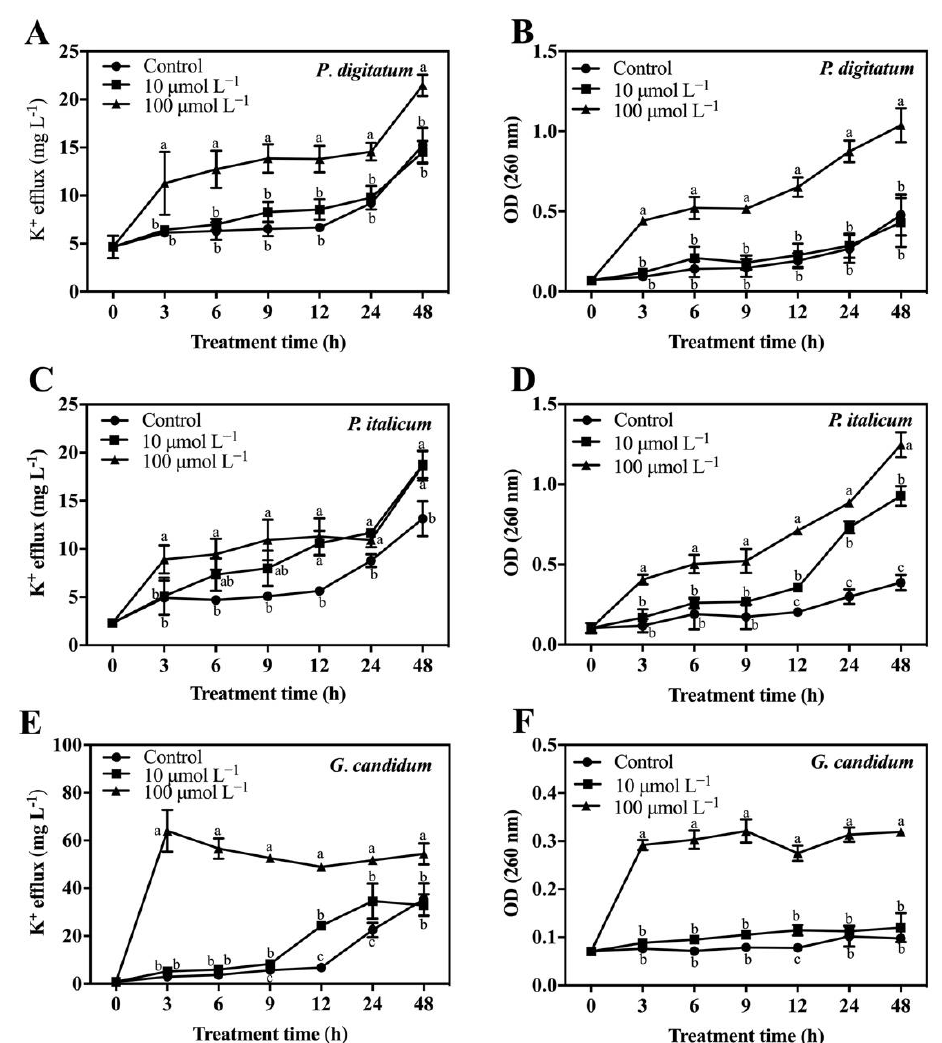
Figure 3. K + efflux and release of cellular constituents of P. digitatum ( A , B ), P. italicum ( C , D ), and G. candidum ( E , F ) mycelia treated with PAF56. Mycelia were incubated in 10 μmol L −1 or 100 μmol L −1 or without PAF56 (control) solutions. The mycelia were washed before resuspension in sterilized distilled water (for the measurement of extracellular potassium concentration) or phosphate buffer (0.05 mol L −1 , phosphate, pH 7.0) (for the measurement of the release of cytoplasmic constituents). The concentration of free K + in the suspensions without mycelia was measured by flame atomic absorption spectroscopy, and the release of cytoplasmic constituents was measured using a Multiskan Spectrum microplate spectrophotometer at 260 nm. Vertical bars indicate the standard error of the means. The letters ‘a’, ‘b’, and ‘c’ indicate significant differences at the 0.05 level.